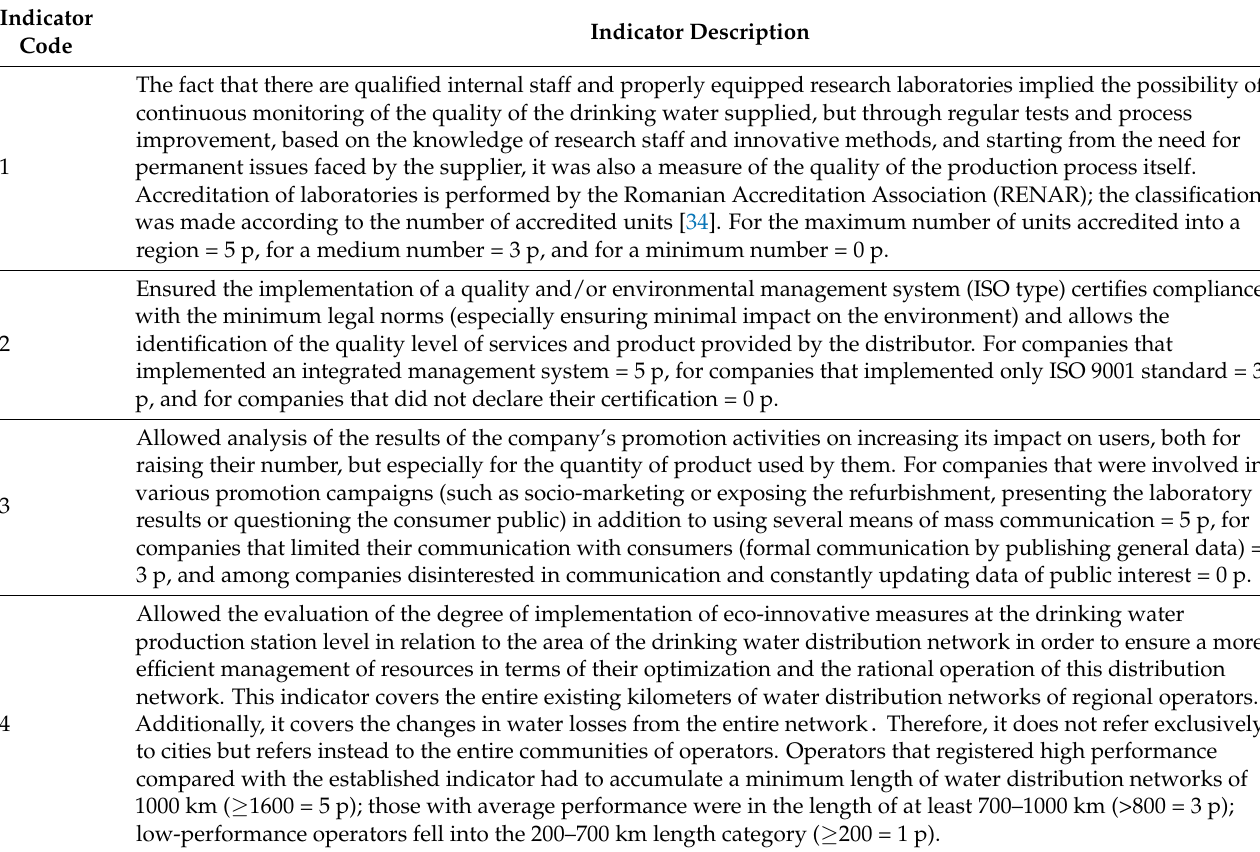
Table 1. Description of the eco-innovation indicators